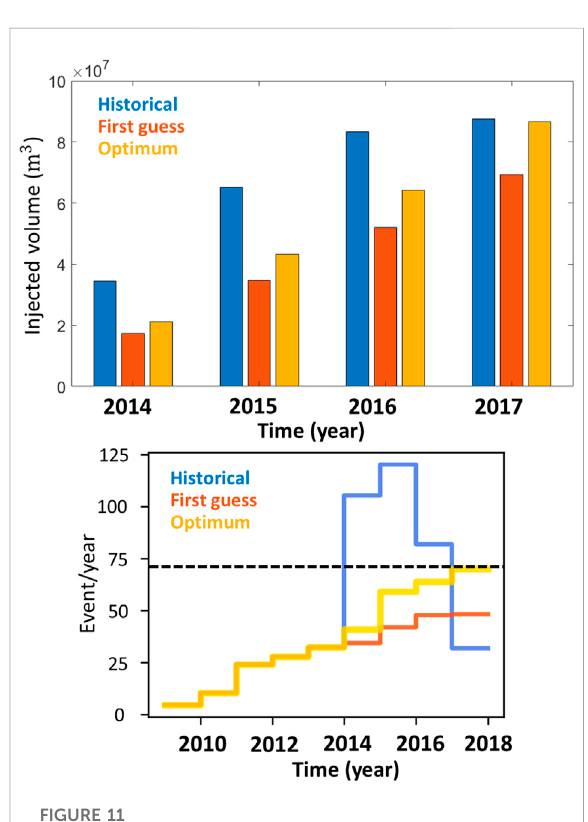
Frontiers in Earth